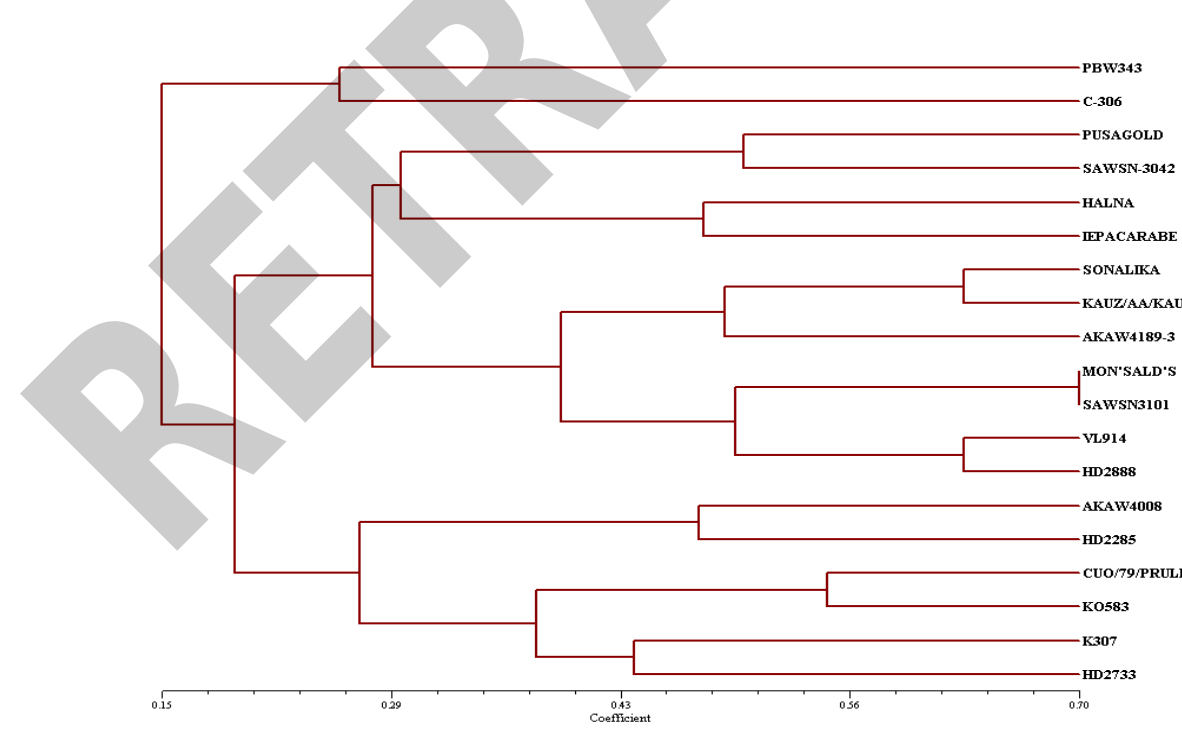
Figure 1: Dendrogram of 19 wheat genotypes showing genetic similarity based on 89 alleles detected by 17 microsatellite primers using Jaccard’s coefficient and